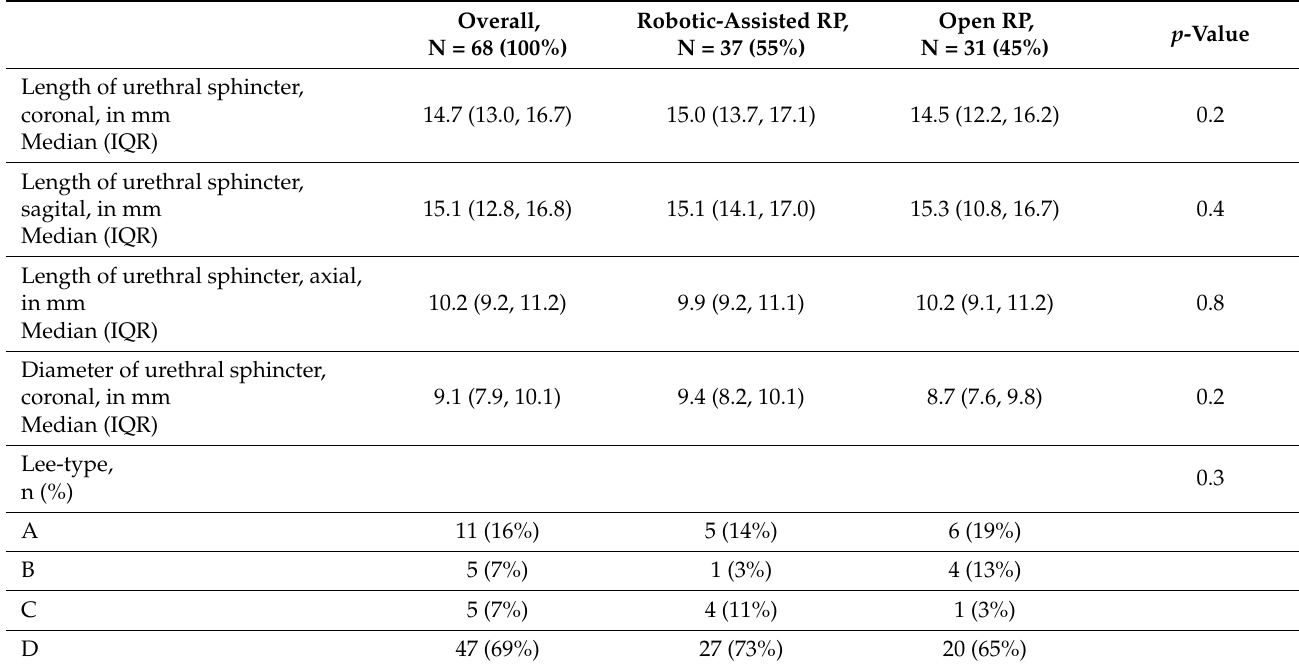
Table 1. Patient and clinicopathological characteristics of 86 radical prostatectomy patients between 03/2018 and 12/2019, stratified according to surgical approach (robotic-assisted vs. open); all values are median (IQR) or frequencies